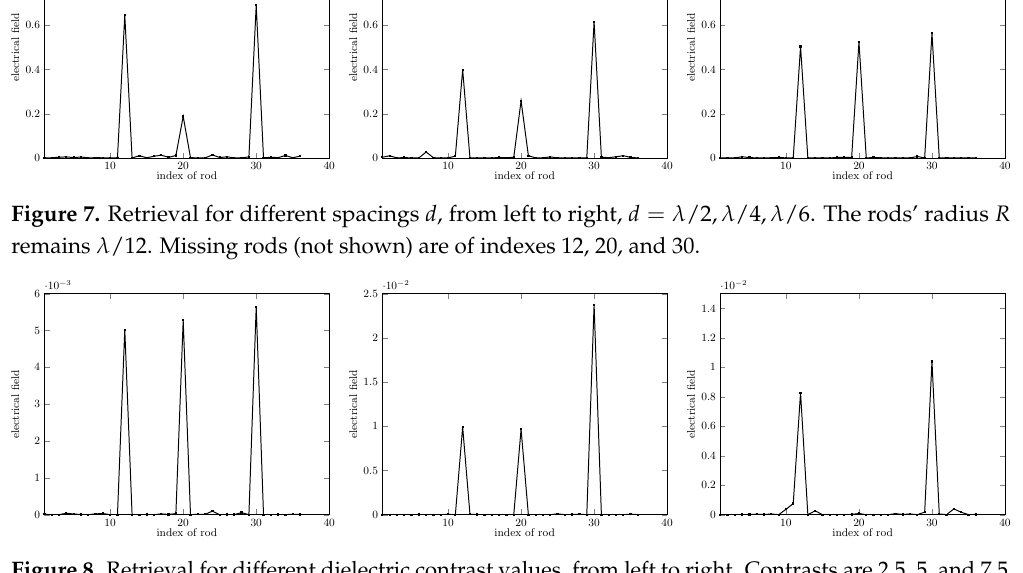
Figure 8. Retrieval for different dielectric contrast values, from left to right. Contrasts are 2.5, 5, and 7.5, respectively. Missing rods (not shown) are of indexes 12, 20, and